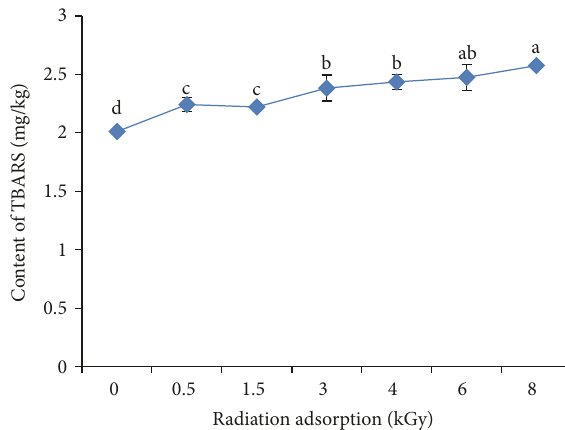
Figure 5: Effect of irradiation on capsanthin of SBJ. Values are represented as mean ± SD. Significance was tested by Duncan Multiple Range Test at 𝑃 < 0.05 , and values with the same superscript were found not significantly different from each other.